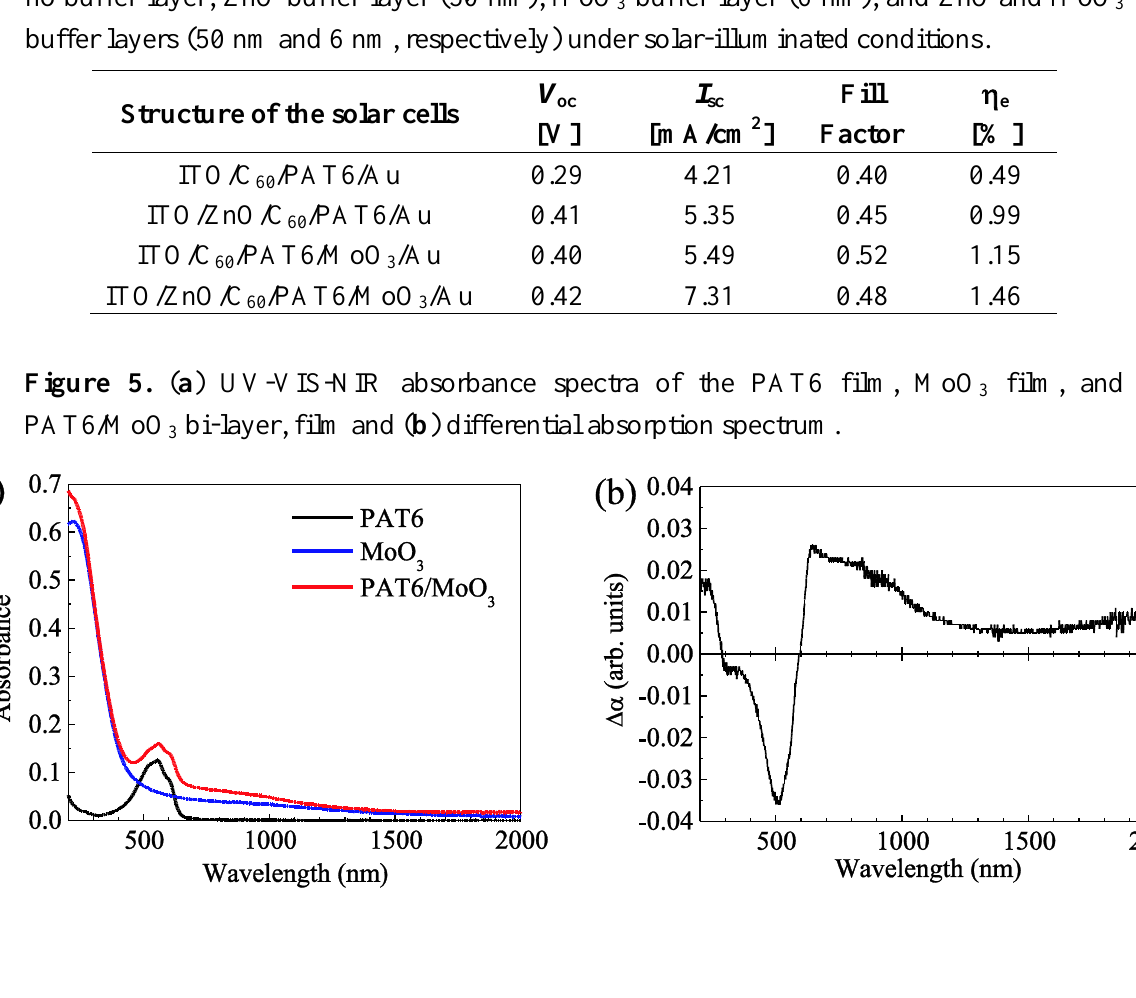
buffer layer (6 nm), and ZnO and MoO 3 3